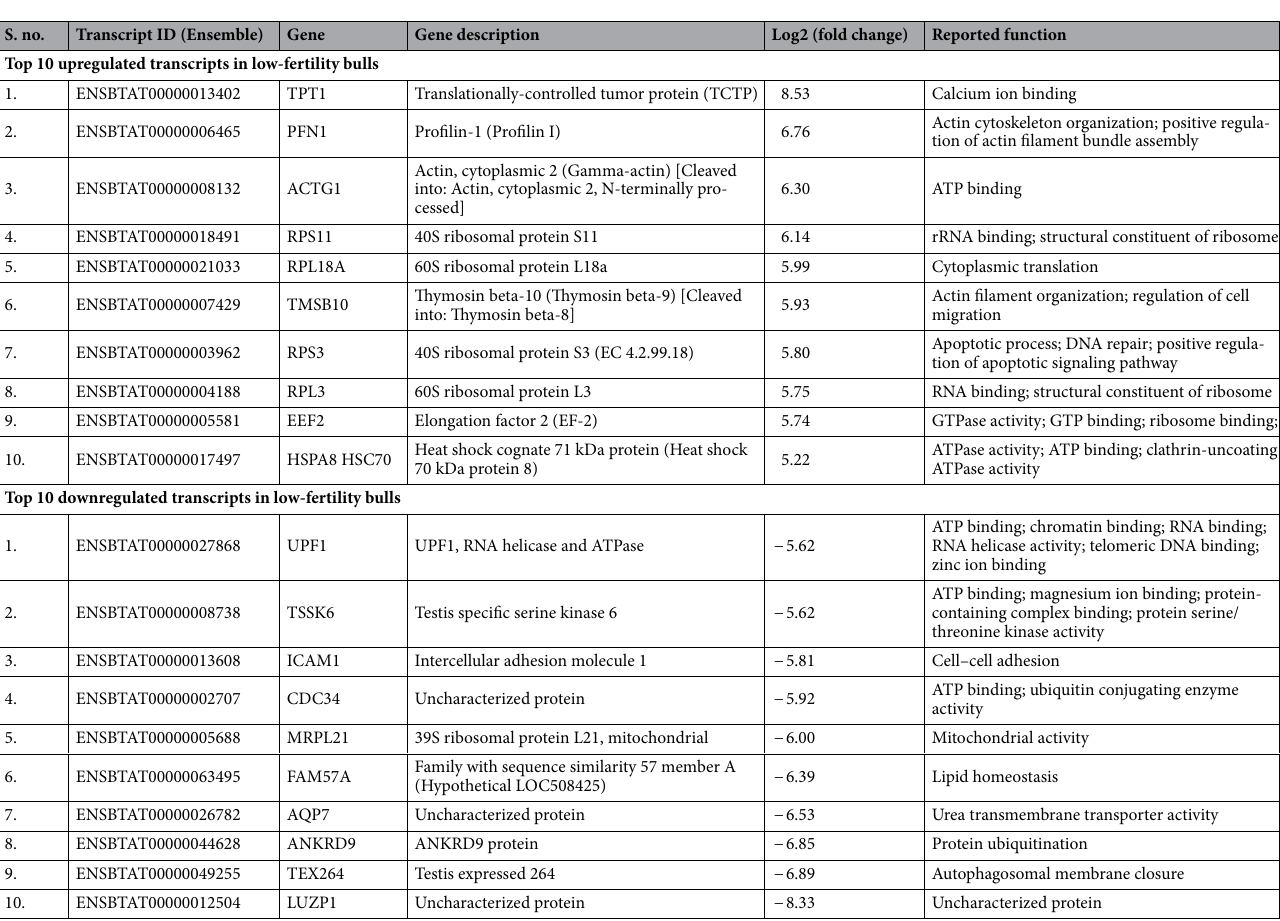
Table 1. Top 10 upregulated and down regulated transcripts in low-fertility